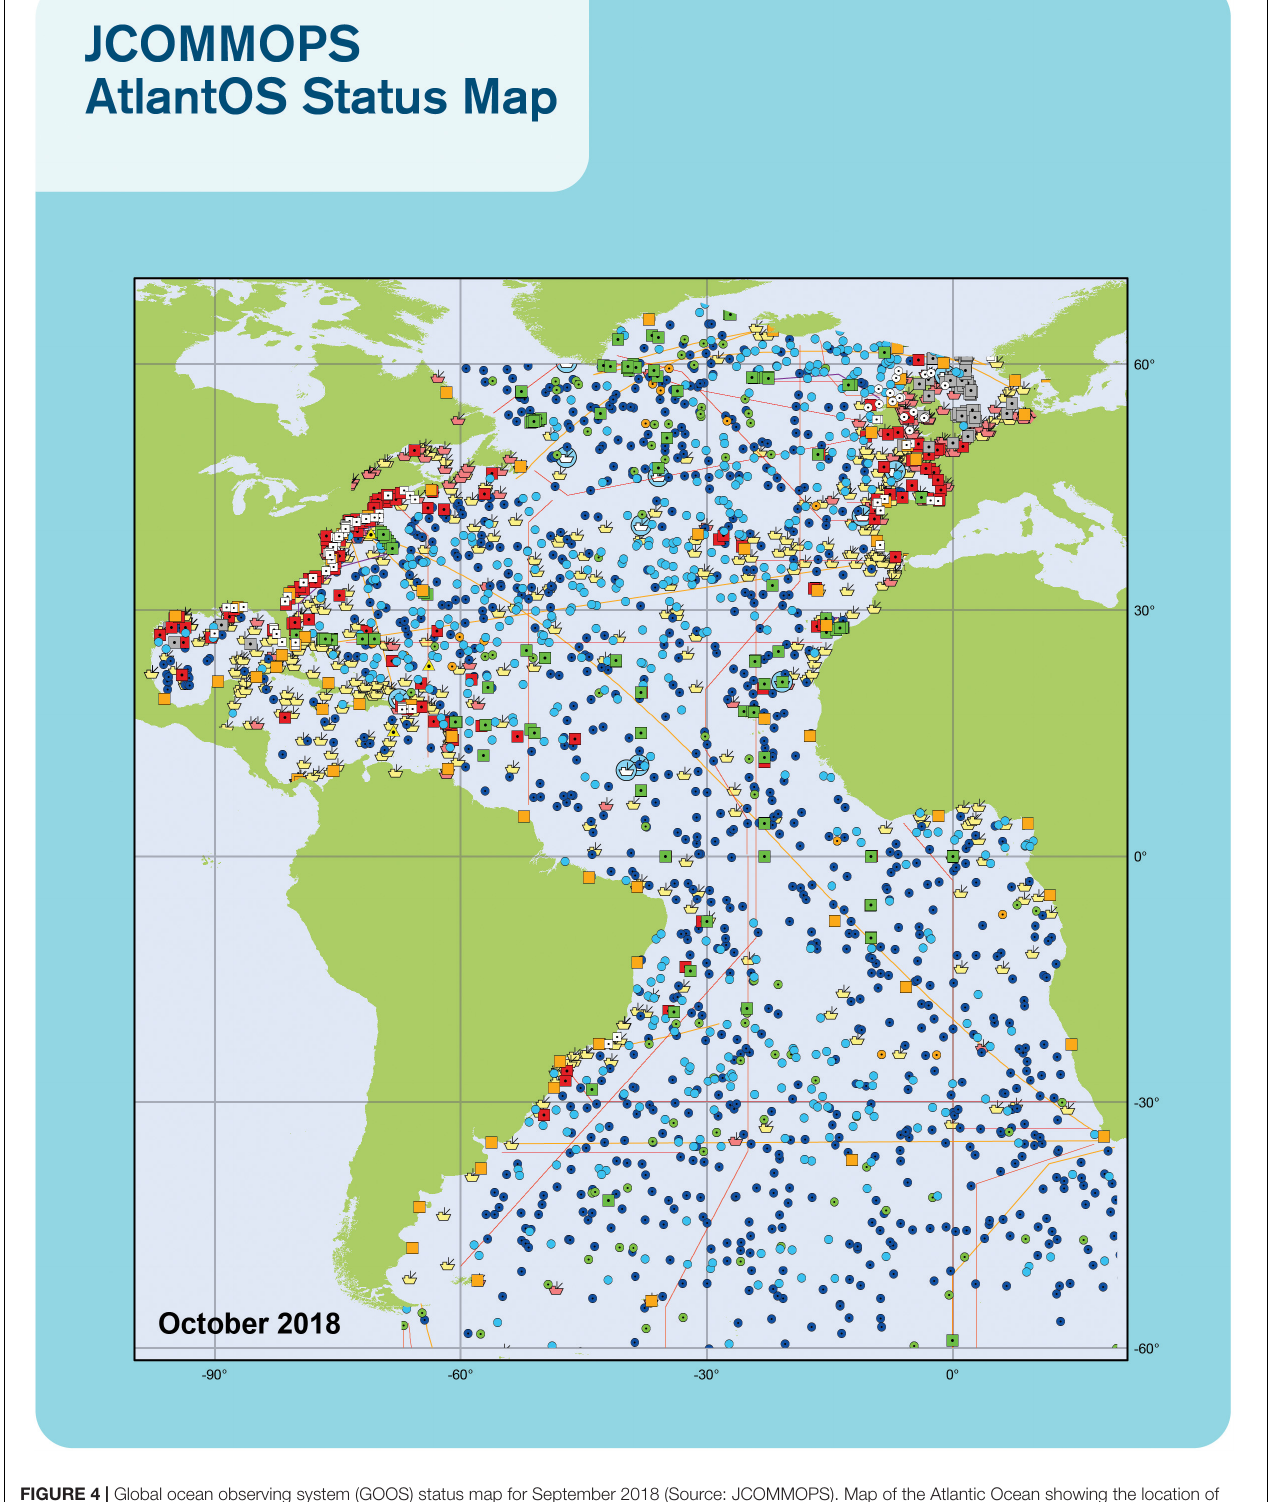
FIGURE 4 | Global ocean observing system (GOOS) status map for September 2018 (Source: JCOMMOPS). Map of the Atlantic Ocean showing the location of ocean platforms (drifters, moorings, buoys, etc.) with onboard instruments collecting ocean observations. Coverage map is of observing activities by GOOS network